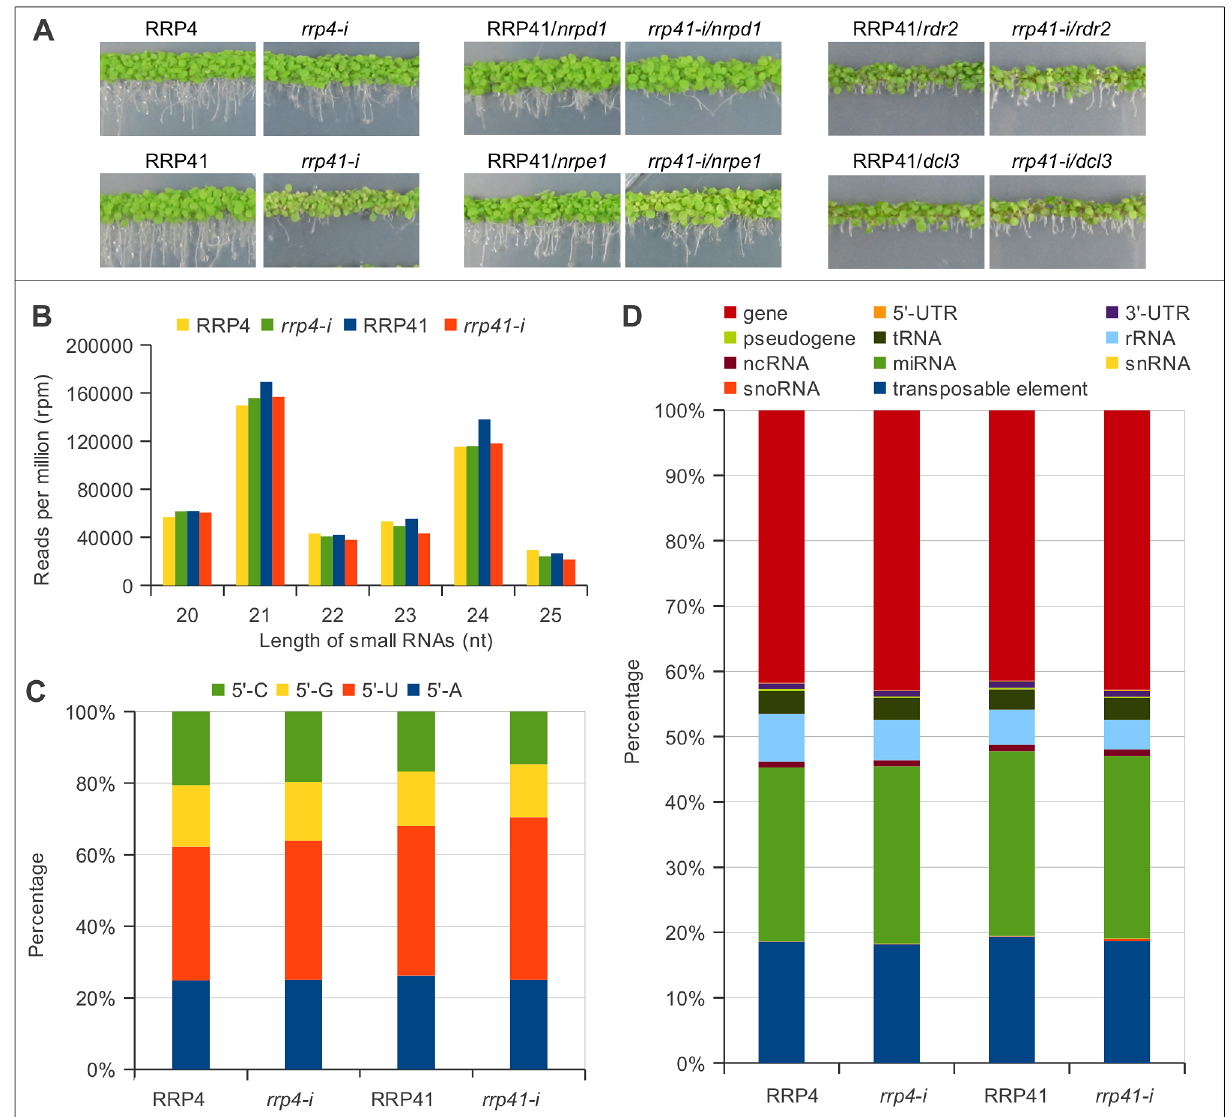
Figure 1. Characterization of up-regulated loci and smRNA populations upon depletion of exosome subunits RRP4 and RRP41. (A) Phenotypes of rrp41 iRNAi/nrpd1, rrp41 iRNAi/nrpe1, rrp41 iRNAi/dcl3, rrp41 iRNAi/rdr2 double mutants. RRP4 and RRP41 correspond to the iRNAi lines grown without estradiol and rrp4-i and rrp41-i correspond to lines grown on estradiol-containing medium, to induce the RNAi-mediated knockdown of RRP4 and RRP41 , respectively. (B) 20–25 nt smRNAs sequences profiled by size in exosome depletion mutants rrp4-i and rrp41-i . (C) The relative frequency of each 5 9 terminal nucleotide among populations 20–25 nt smRNAs in rrp4-i and rrp41-i mutants. (D) Genomic features of loci generating 20–25 nt small RNAs upon depletion of exosome subunits, according to TAIR9 annotation units.